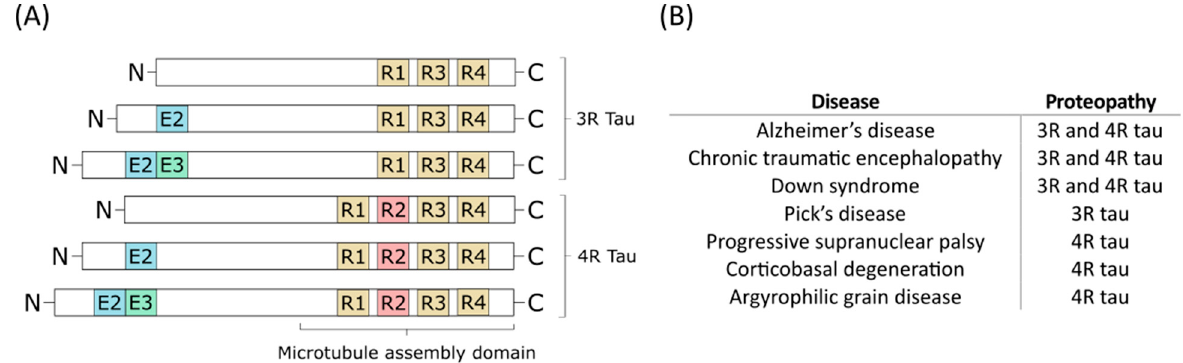
Figure 1. ( A ) The six different tau isoforms of an adult human. Exon 2 (E2), exon 3 (E3), and exon 10 (R2) are indicated in blue, green, and red, respectively. Alternative splicing creates the different isoforms which can be divided into 3-repeat (3R) tau and 4-repeat (4R) tau. ( B ) Different diseases can involve only 3R tau or 4R tau, or both of them as the main proteopathy [7].